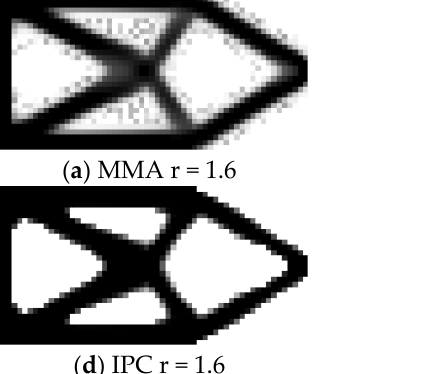
Figure 7. Optimized designs of the cantilever beam using IPC and MMA methods.